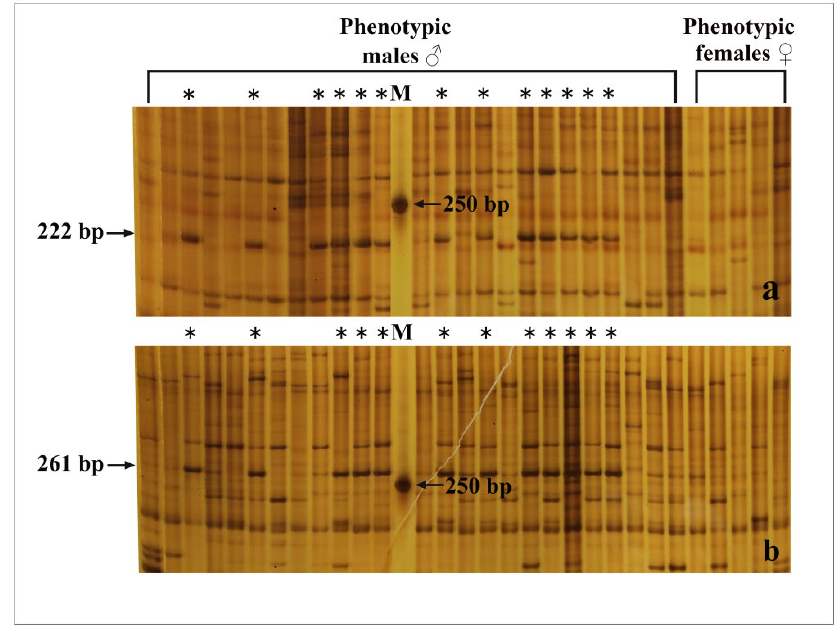
Figure 2. Polyacrylamide gel electrophoresis (PAGE) images of R. dybowskii amplified with two primer combinations. ( a ) Male-linked molecular marker (222 bp) obtained with the primer combination-1. ( b ) Male-linked molecular marker (261 bp) obtained with the primer combination-2. The individuals with ‘*’ were amplified with the male-specific markers. Table 1. R. dybowskii individuals were selected for transcriptome